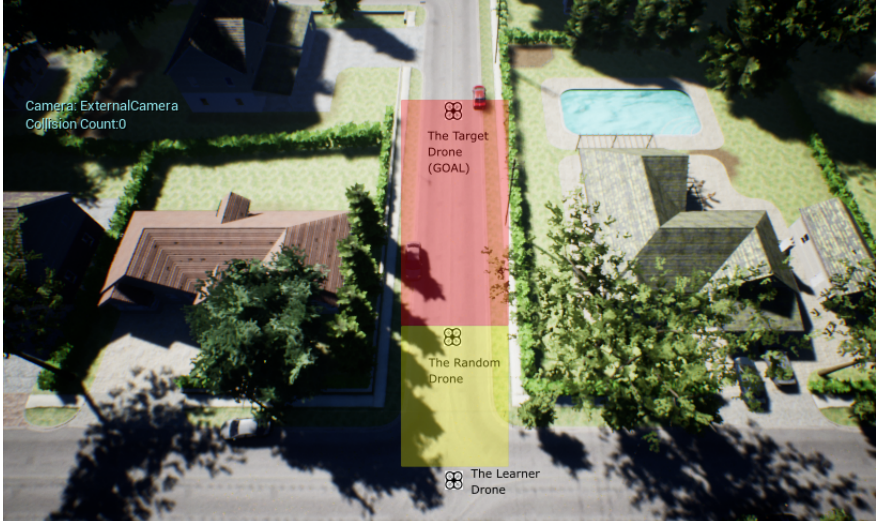
Figure 10. The environment with Random Drone, Target drone and the Learner